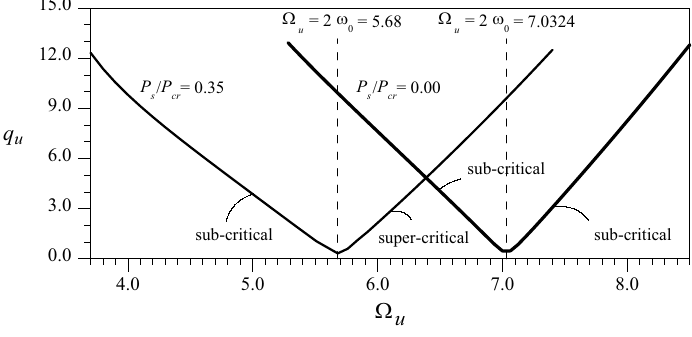
Fig. 13. Parametric instability boundary in the force control space, for an axial static load P s /P cr = 0.35 (case 3). to the classical resonance curve obtained when the flexural-flexural-torsional coupling is not considered, leading to an erroneous description of the beam oscillations. If only in-plane motions are considered in the structural modeling, only two saddle-node bifurcations occur, which correspond in Fig. 15(a) to the points PF1 and PF2. When the flexural-flexural-torsional coupling is considered, these saddle-node bifurcations change to unstable pitchfork bifurcations, leading to nonplanar motions (blue and red branches in Fig. 15(a)). Due to the inherent symmetries of the system the two branches of non-planar motions are superimposed in Fig. 15(a). Only a phase difference exists between the two solutions. As expected, they undergo the same sequence of saddle-node bifur- cations (SN), leading to a region of stable non-planar motions (between SN1 = SN3 and SN2 = SN4). As the load increases, new bifurcated paths appear, as shown in Figs 15(b)–(c). These bifurcated paths also exhibit several secondary